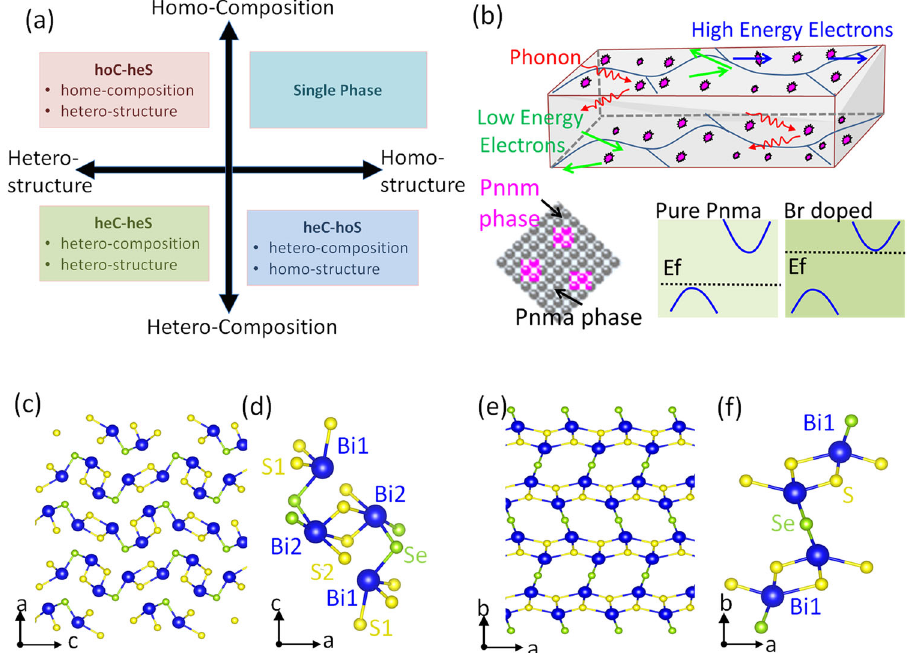
Fig. 1 Schematic representation of the nanocomposition and crystal structure of Bi 2 SeS 2 . a Summary of previously reported nanocomposites classi fi ed by the composition and crystal structure of their nanoinclusion and matrix. Most reported nanocomposites are hetero-composition and homo-structure ( he C- ho S) or hetero-composition and hetero-structure ( he C- he S). b Structure and schematic illustration of transport mechanism inside Pnma Bi 2 SeS 2 - Pnnm Bi hoC - heS nanocomposite. c – d Crystal structure of Bi Pnma phase in the ac plane. e – f Crystal structure of Bi Pnnm phase in the 2 SeS 2 2 SeS 2 2 SeS 2 ab